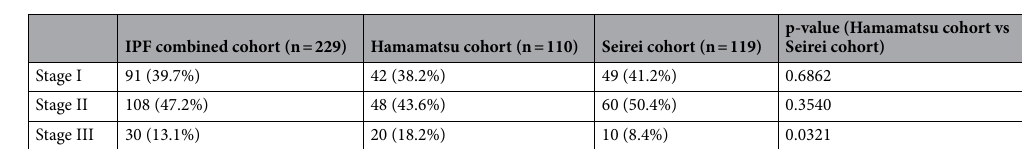
Table 2. GAP stage in patients with IPF at initiations of antifibrotic therapy. GAP